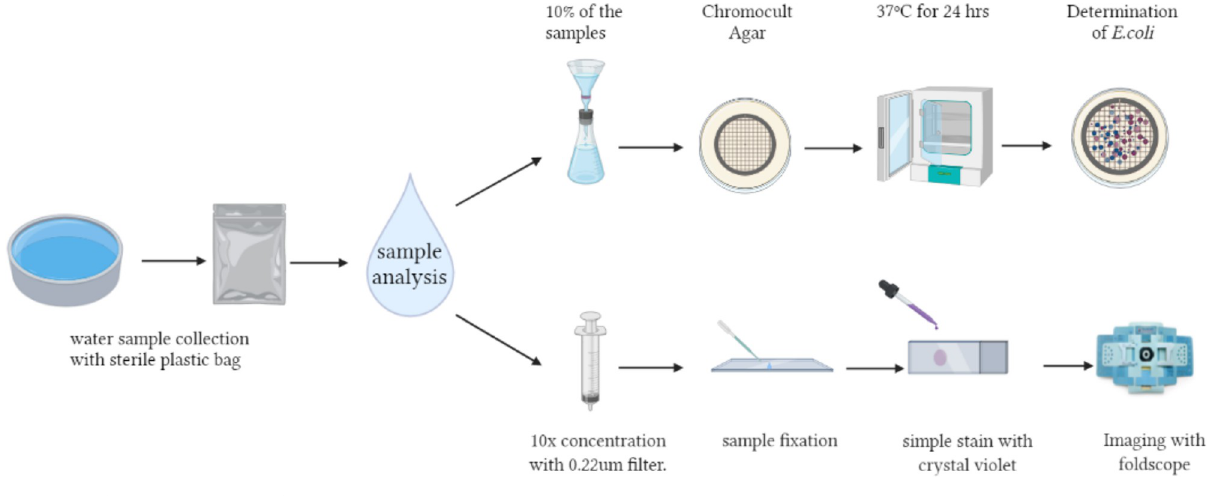
Fig 4. Sample processing